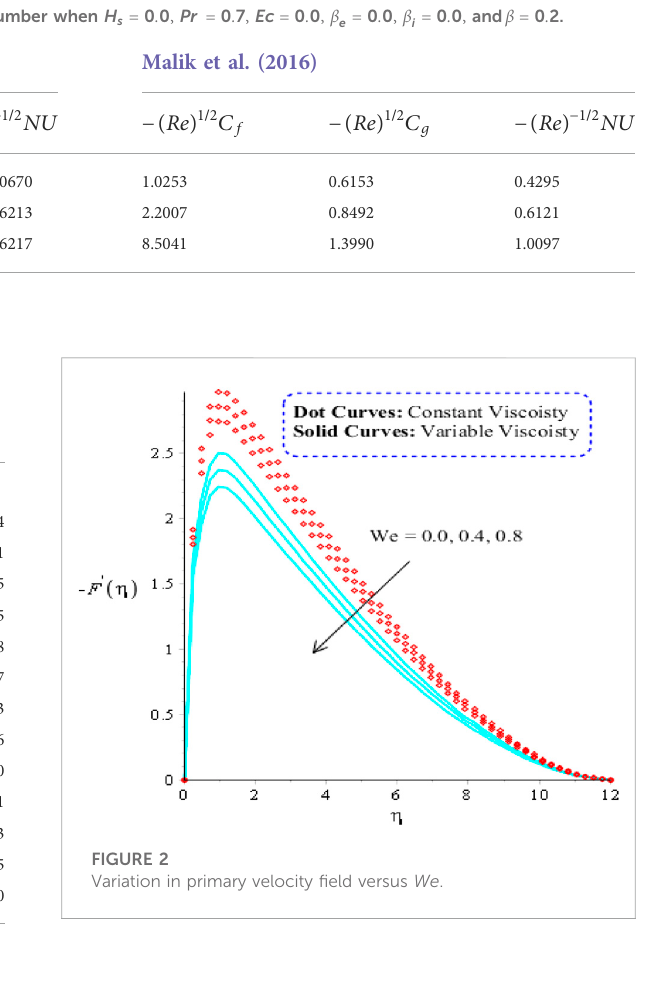
TABLE 1 Validation of results in term of shear stresses and Nusselt number when H s (cid:1) 0 . 0 , Pr (cid:1) 0 . 7 , Ec (cid:1) 0 . 0 , β e (cid:1) 0 . 0 , β i (cid:1) 0 . 0 , and β (cid:1) 0 . 2.